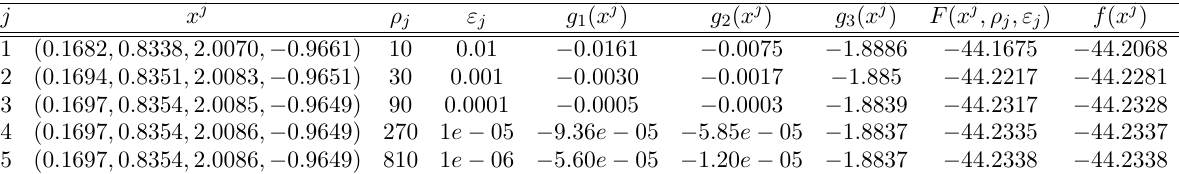
Table 5. Table of minimization process of the Problem